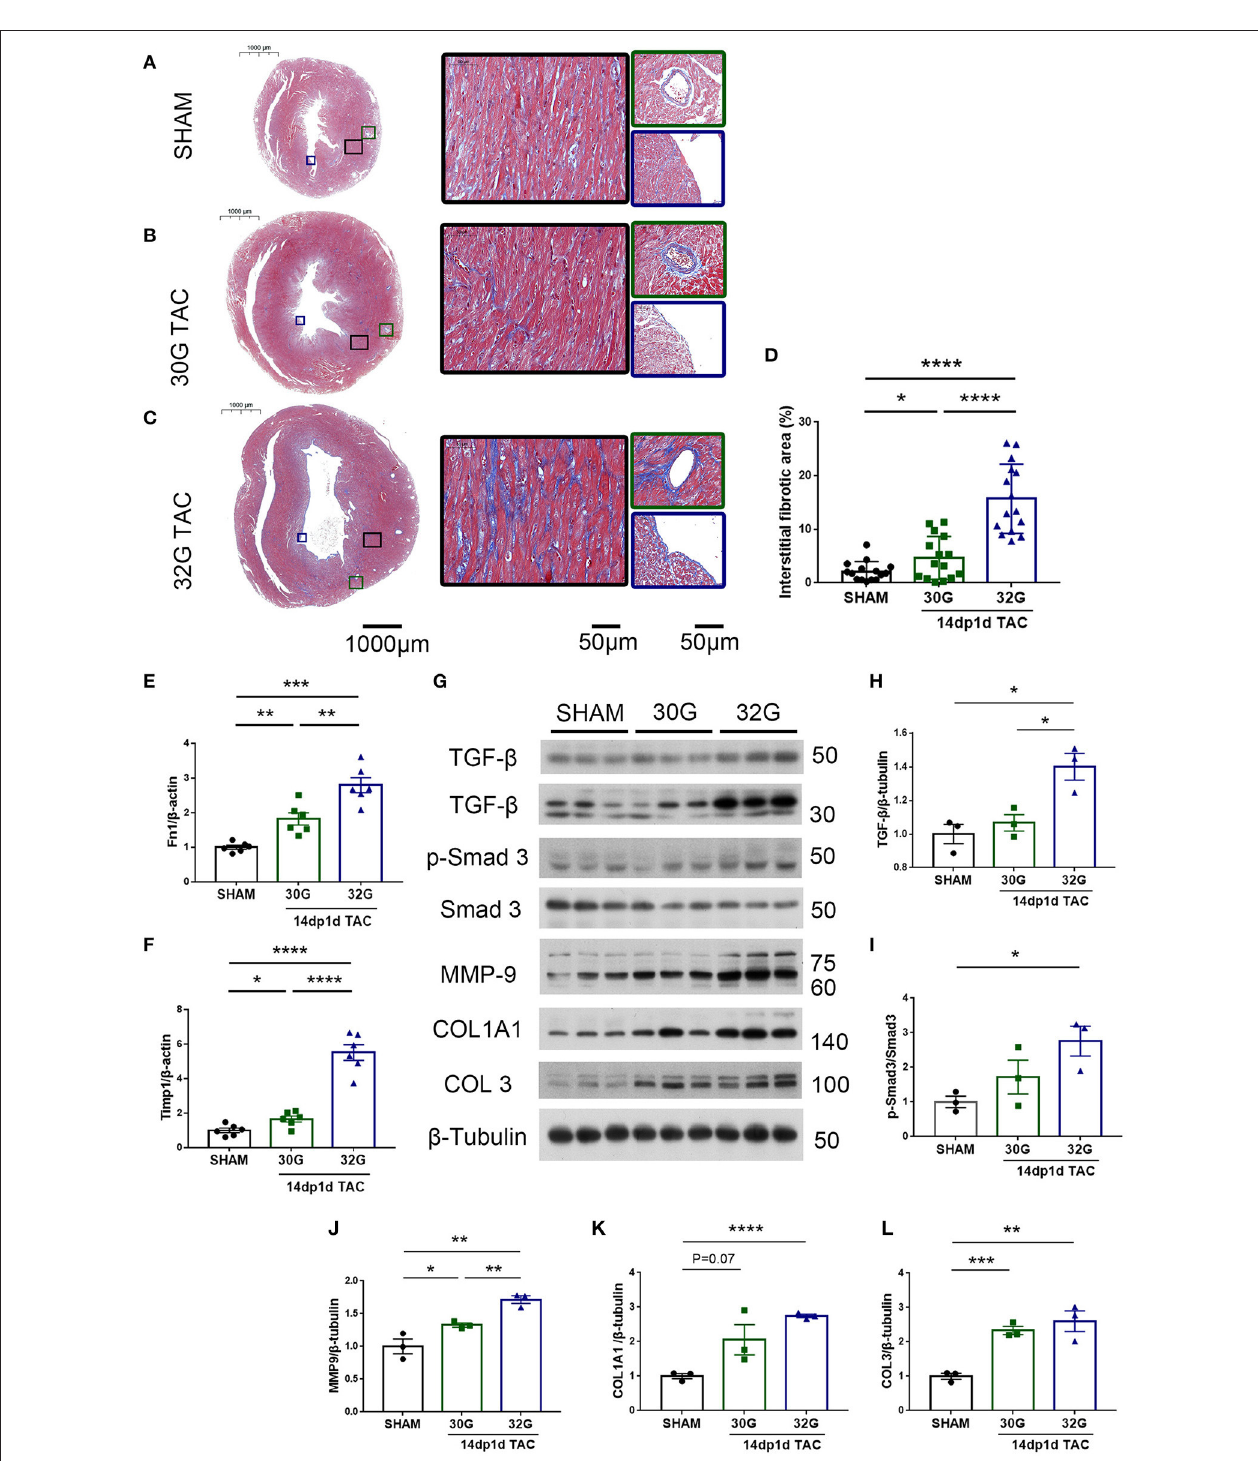
FIGURE 8 | Hearts of mice in the 32G TAC group had more fibrosis markers compared with those in the sham and 30G TAC groups. (A–C) Representative Masson staining of hearts of mice in the sham (A) , 30G TAC (B) , and 32G TAC (C) groups. The middle images are high-power fields of the corresponding left images (black square frame), showing interstitial fibrosis. The right images are high-power fields of the corresponding left images, showing perivascular fibrosis (green square frame, up) and endomyocardial fibrosis (blue square frame, down). Scale bar: 100 µ m (left images); scale bar: 50 µ m (middle and right images). (D) Interstitial fibrosis in the three groups; n = 3 hearts per group. Each heart slide was random selected with five high-power fields for statistical analysis. (E,F) qRT-PCR for the expression of